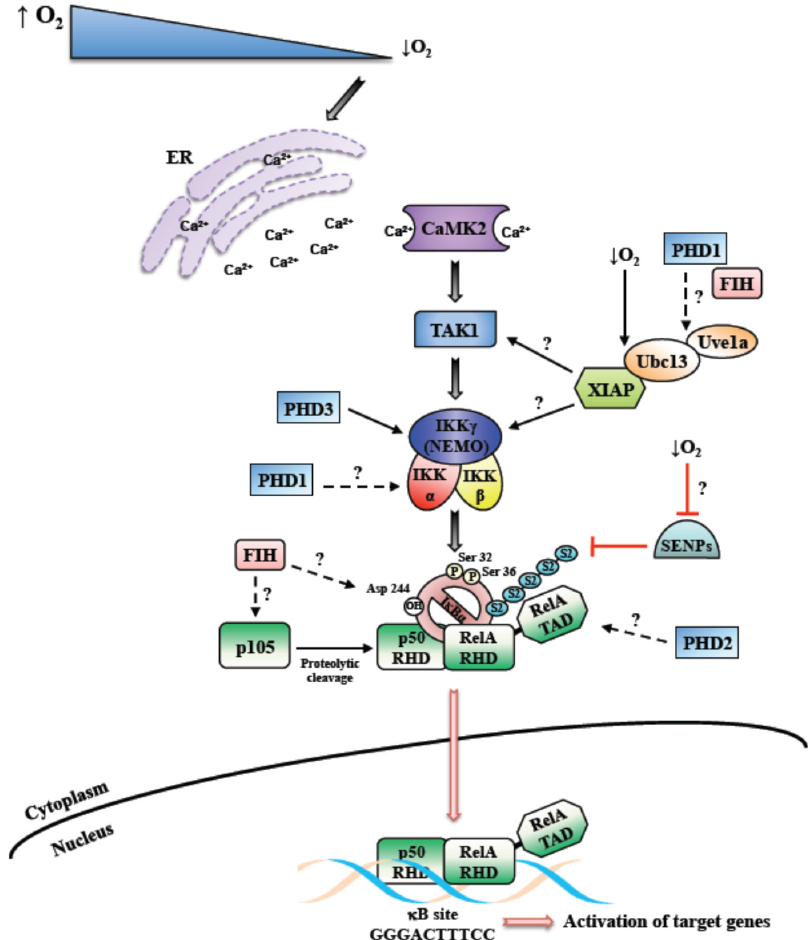
Figure 1. Mechanism of hypoxia induced Nuclear Factor- κ B (NF- κ B). Schematic diagram depicting the overview of the mechanism behind hypoxia induced NF- κ B. Hypoxia induced NF- κ B has been